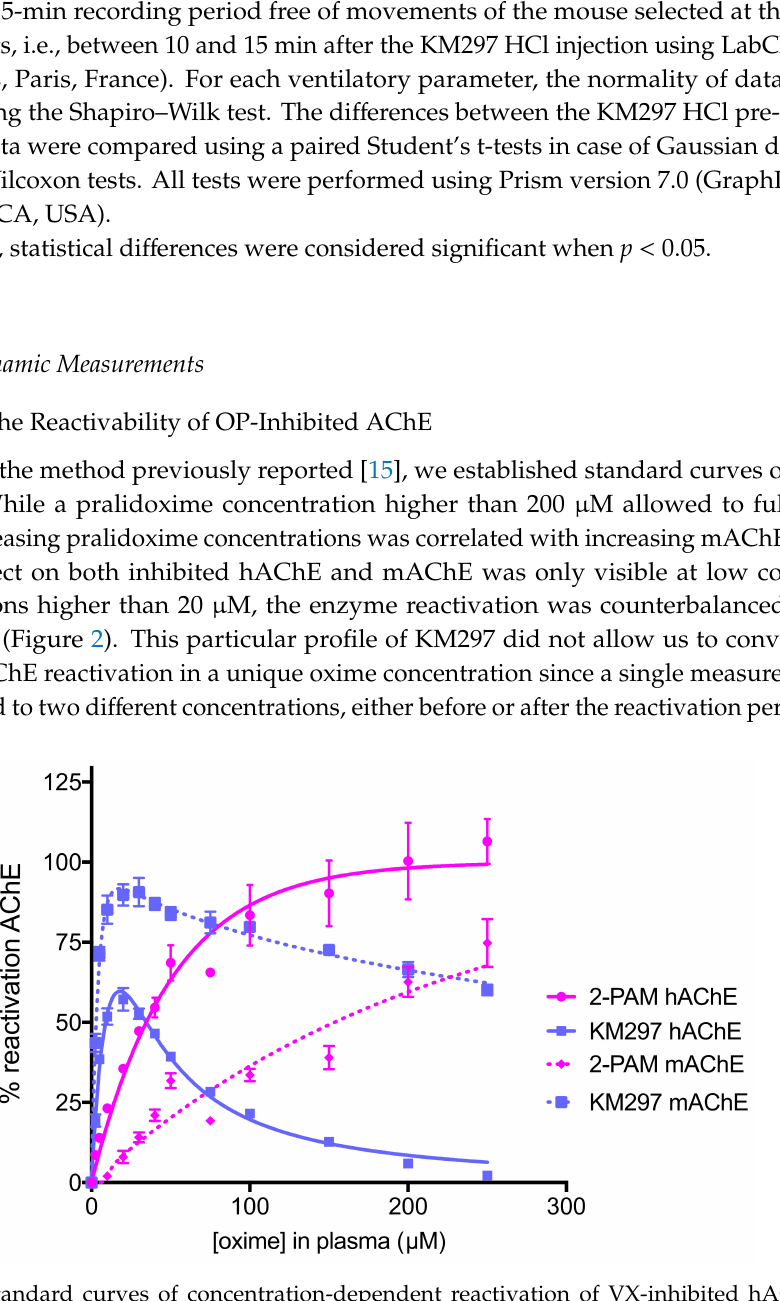
Figure 2. Standard curves of concentration-dependent reactivation of VX-inhibited hAChE and paraoxon-inhibited mAChE by two oximes. VX-inhibited hAChE and paraoxon-inhibited mAChE were incubated with 0–250 µ M of oximes (2-PAM or KM297 HCl) diluted in heat-inactivated mice plasma. The recovered activity was determined after 30 min incubation at 37 ◦ C. The best-fit curves and apparent bimolecular rate constants k r2 were calculated by nonlinear regression using the equation described in part 2.4.1.1 and GraphPad Prism software. Three independent experiments were performed for each oxime and each inhibited enzyme. Values are presented as mean ±